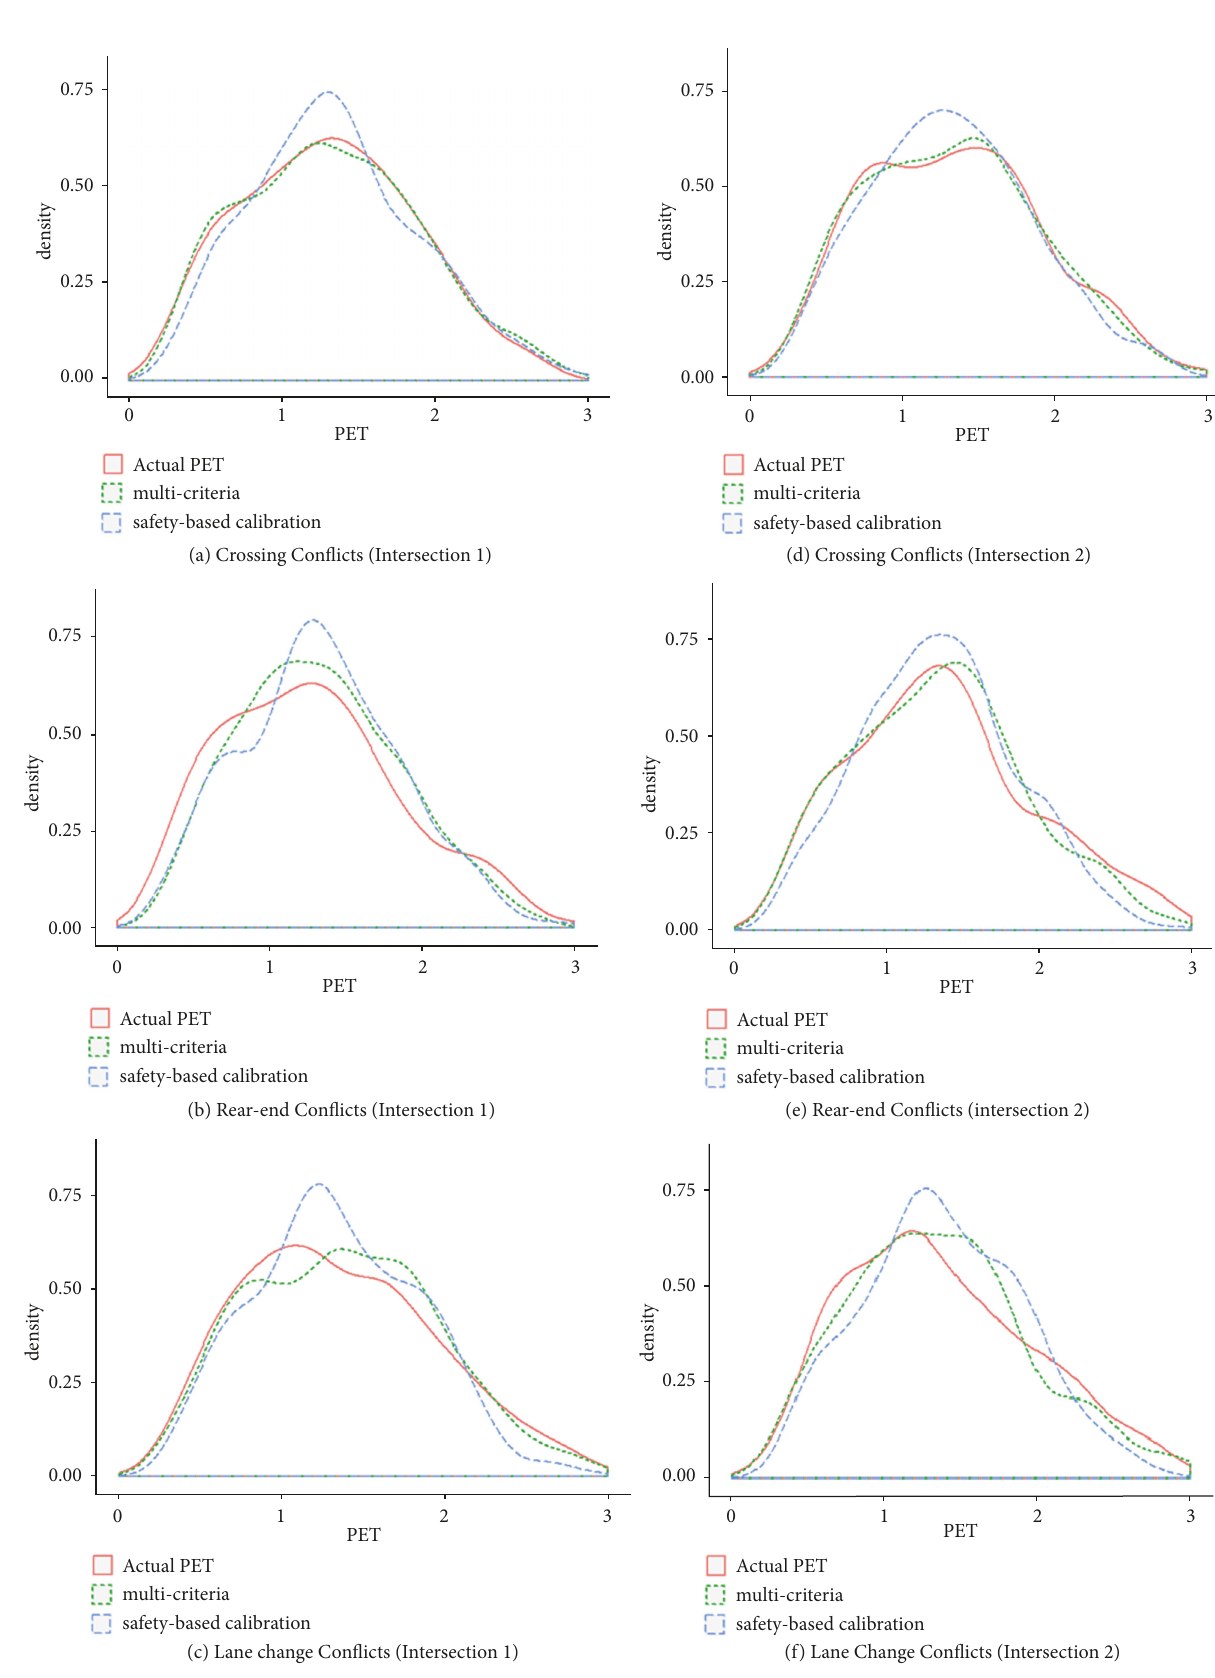
Figure 5: PET distribution of multicriteria calibration, safety-based calibration, and the